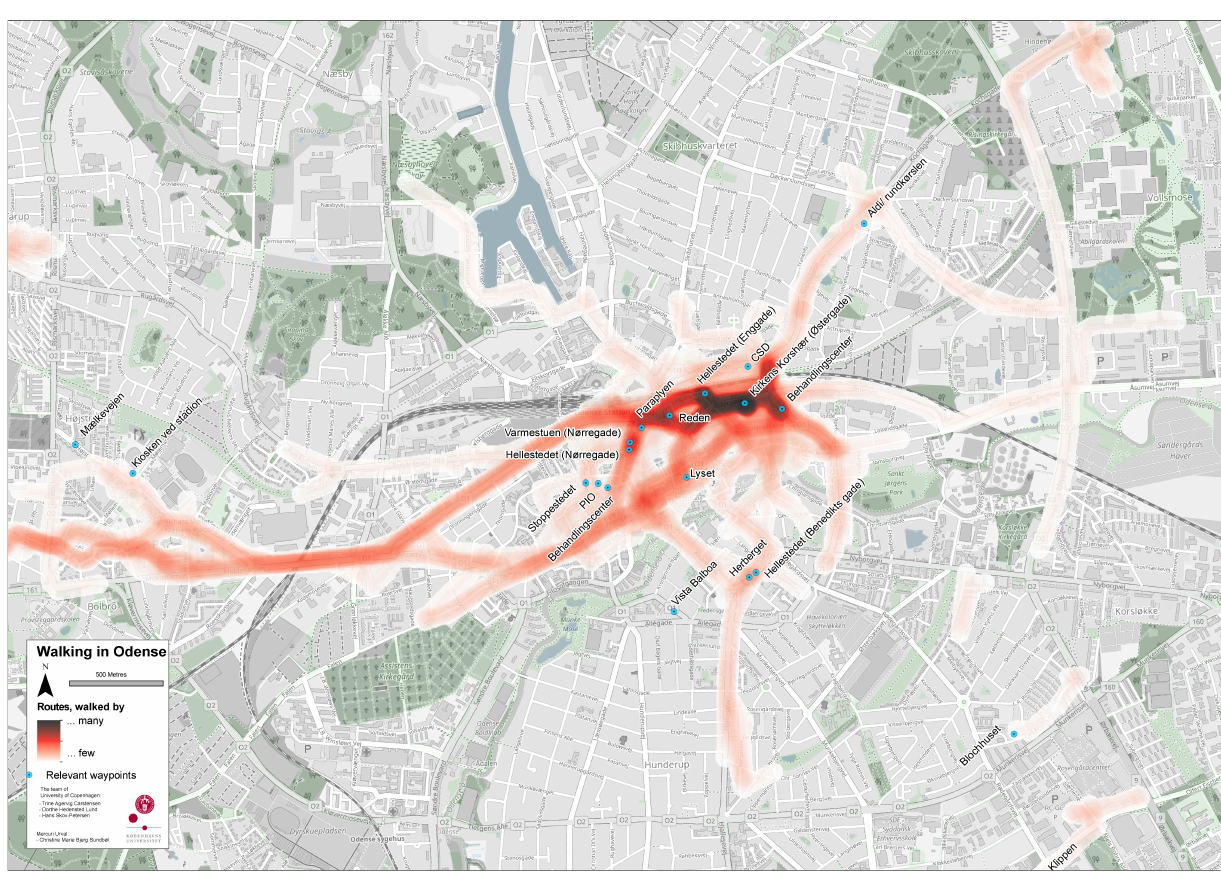
Figure 3. Stops “in town” (not “at home”) in Odense: Entire area of recording. litter negatively impacts their harmonious cohabitation with other citizen